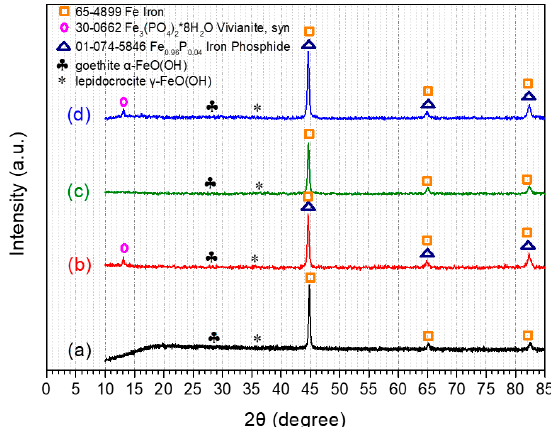
Figure 14. XRD spectra of the mild steel panels after submission in 3.5 wt % NaCl for 96 h: ( a ) Steel–NaCl–blank , ( b ) Steel–NaCl–Na 2 HPO 4 , ( c ) Steel–NaCl–MBT , ( d ) Steel–NaCl–Na 2 HPO 4 –MBT